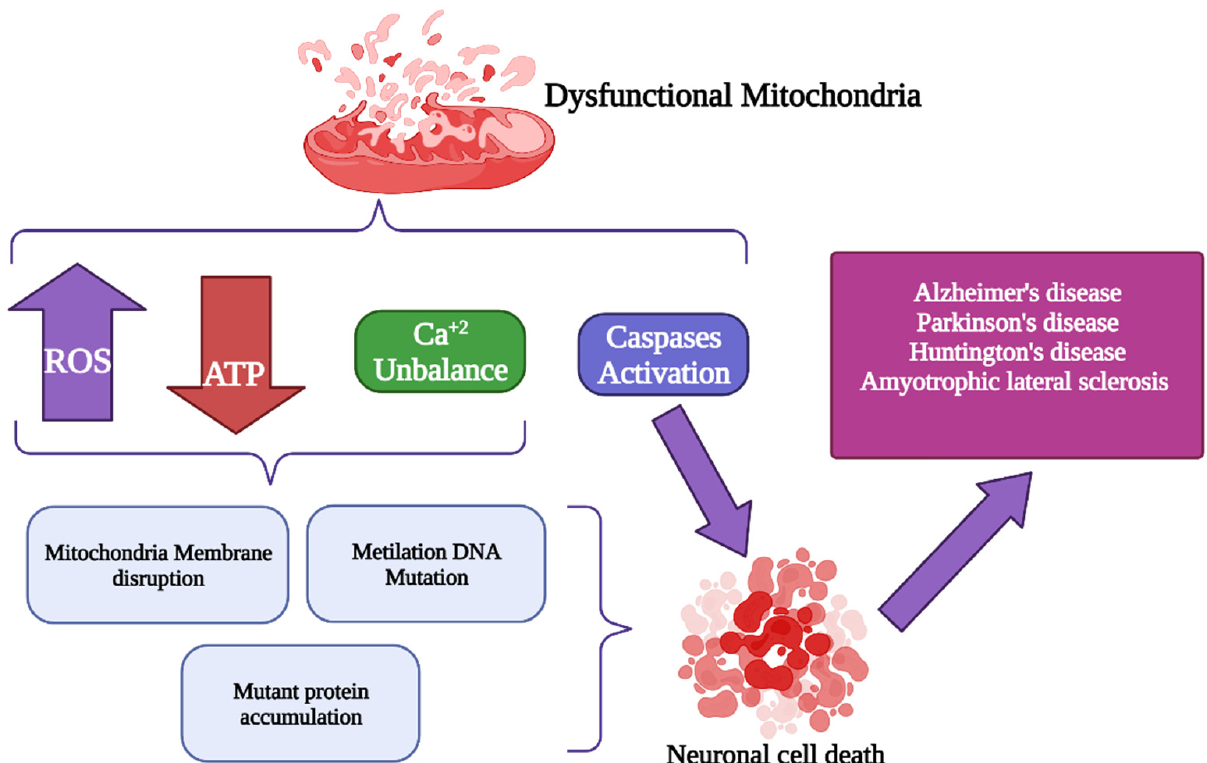
Figure 3. Mitochondrial dysfunction in neurodegenerative diseases. Neurodegenerative diseases such as Alzheimer’s disease, Parkinson’s disease, Huntington’s disease, amyotrophic lateral sclerosis, among others, involve altered signaling of apoptotic proteins, ROS, ATP, and Ca +2 imbalance mechanisms. This pathological imbalance is responsible for mitochondrial dysfunction in neurological